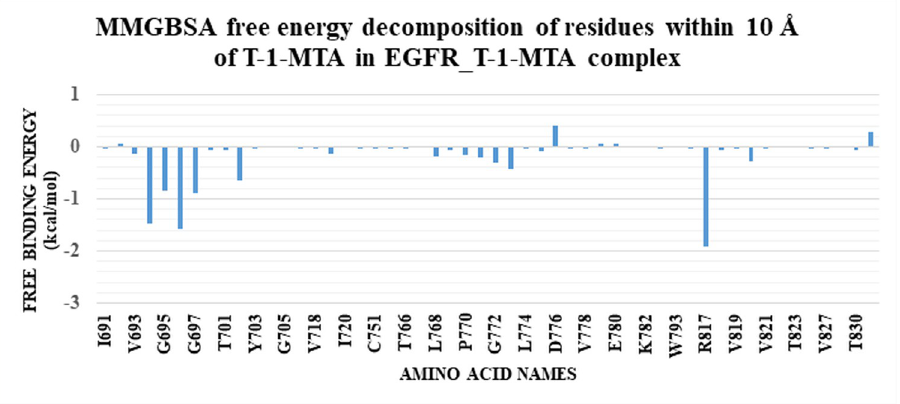
Fig 10. Binding energy decomposition of the EGFR_T-1-MTA